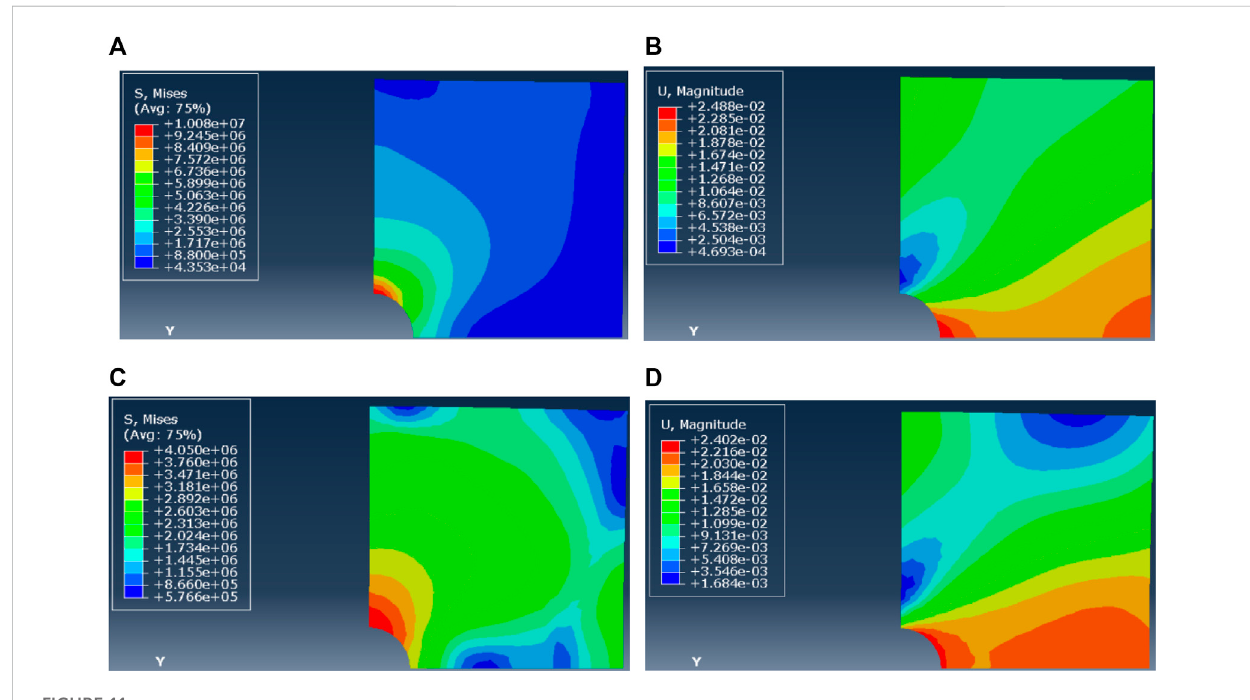
FIGURE 11 (A – D) Mises stress and displacement of borehole shrinkage after reaming ( Δ P = 1 MPa, n = 1). Mises stress and displacement of borehole shrinkage after reaming ( Δ P = 1 MPa, n = 5)